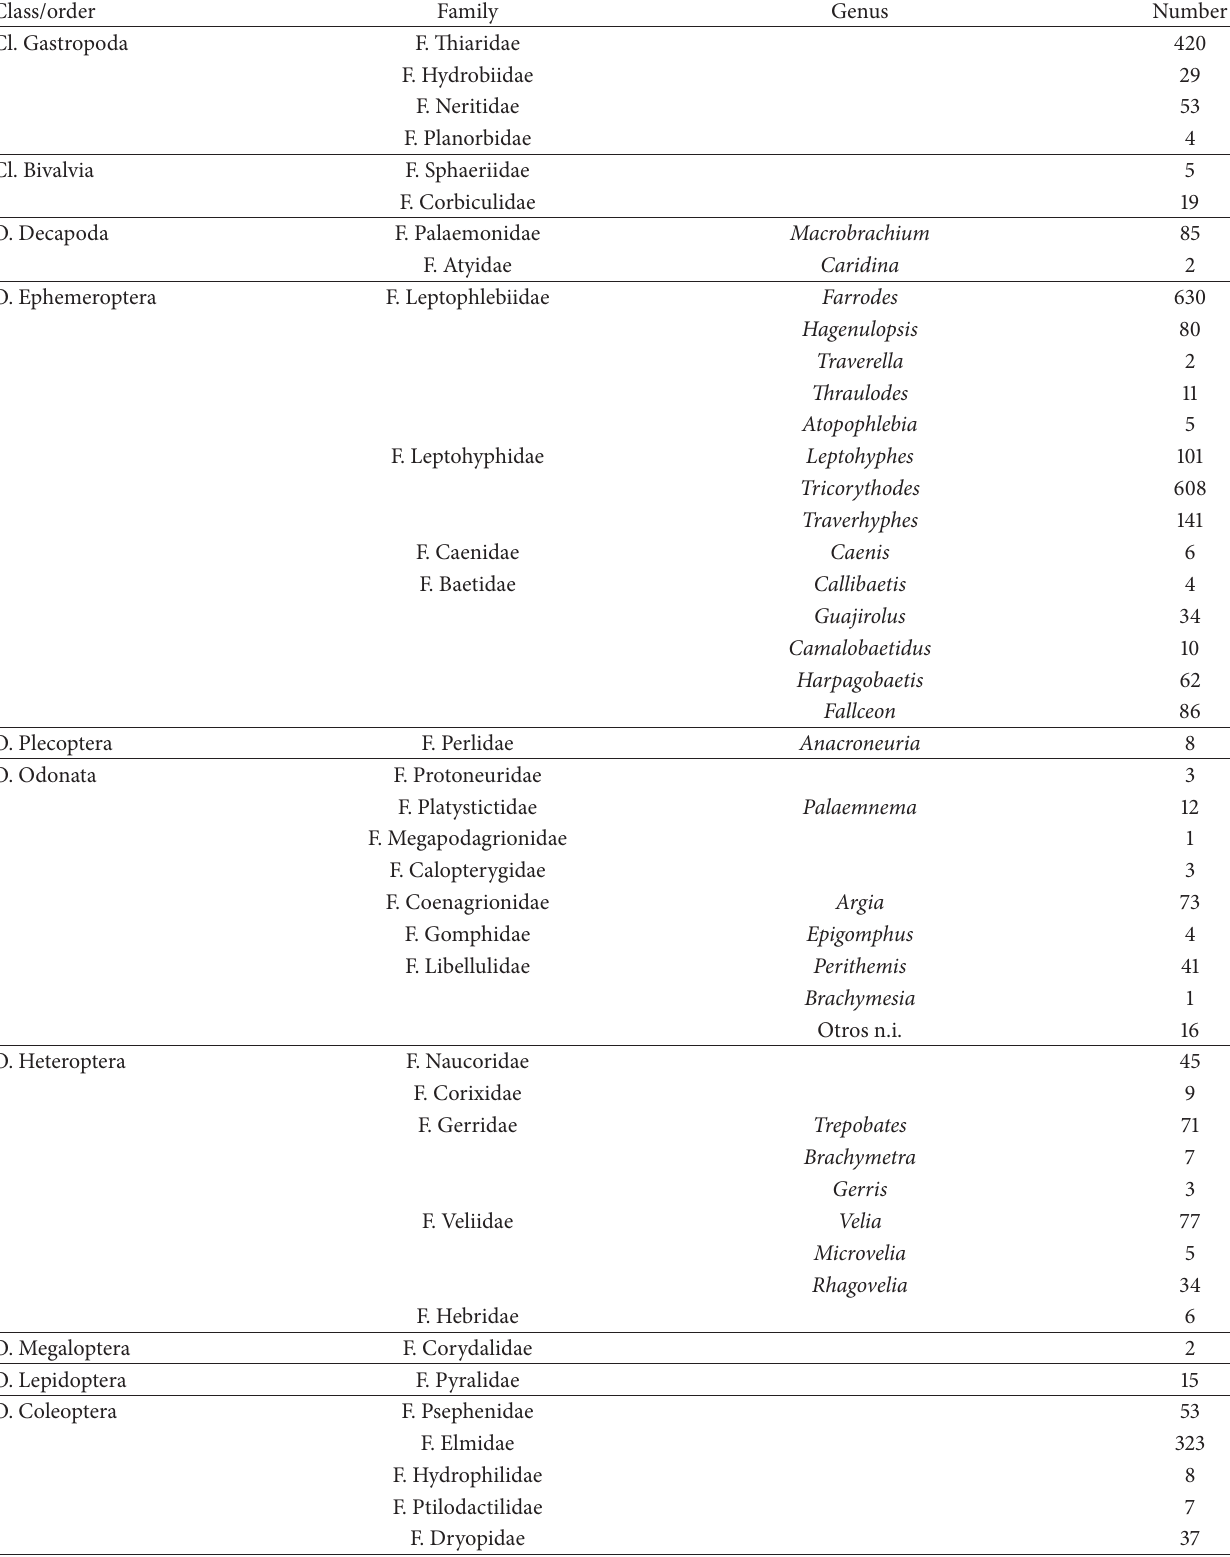
Table 3: Macroinvertebrate taxa and total number of individuals collected in the study